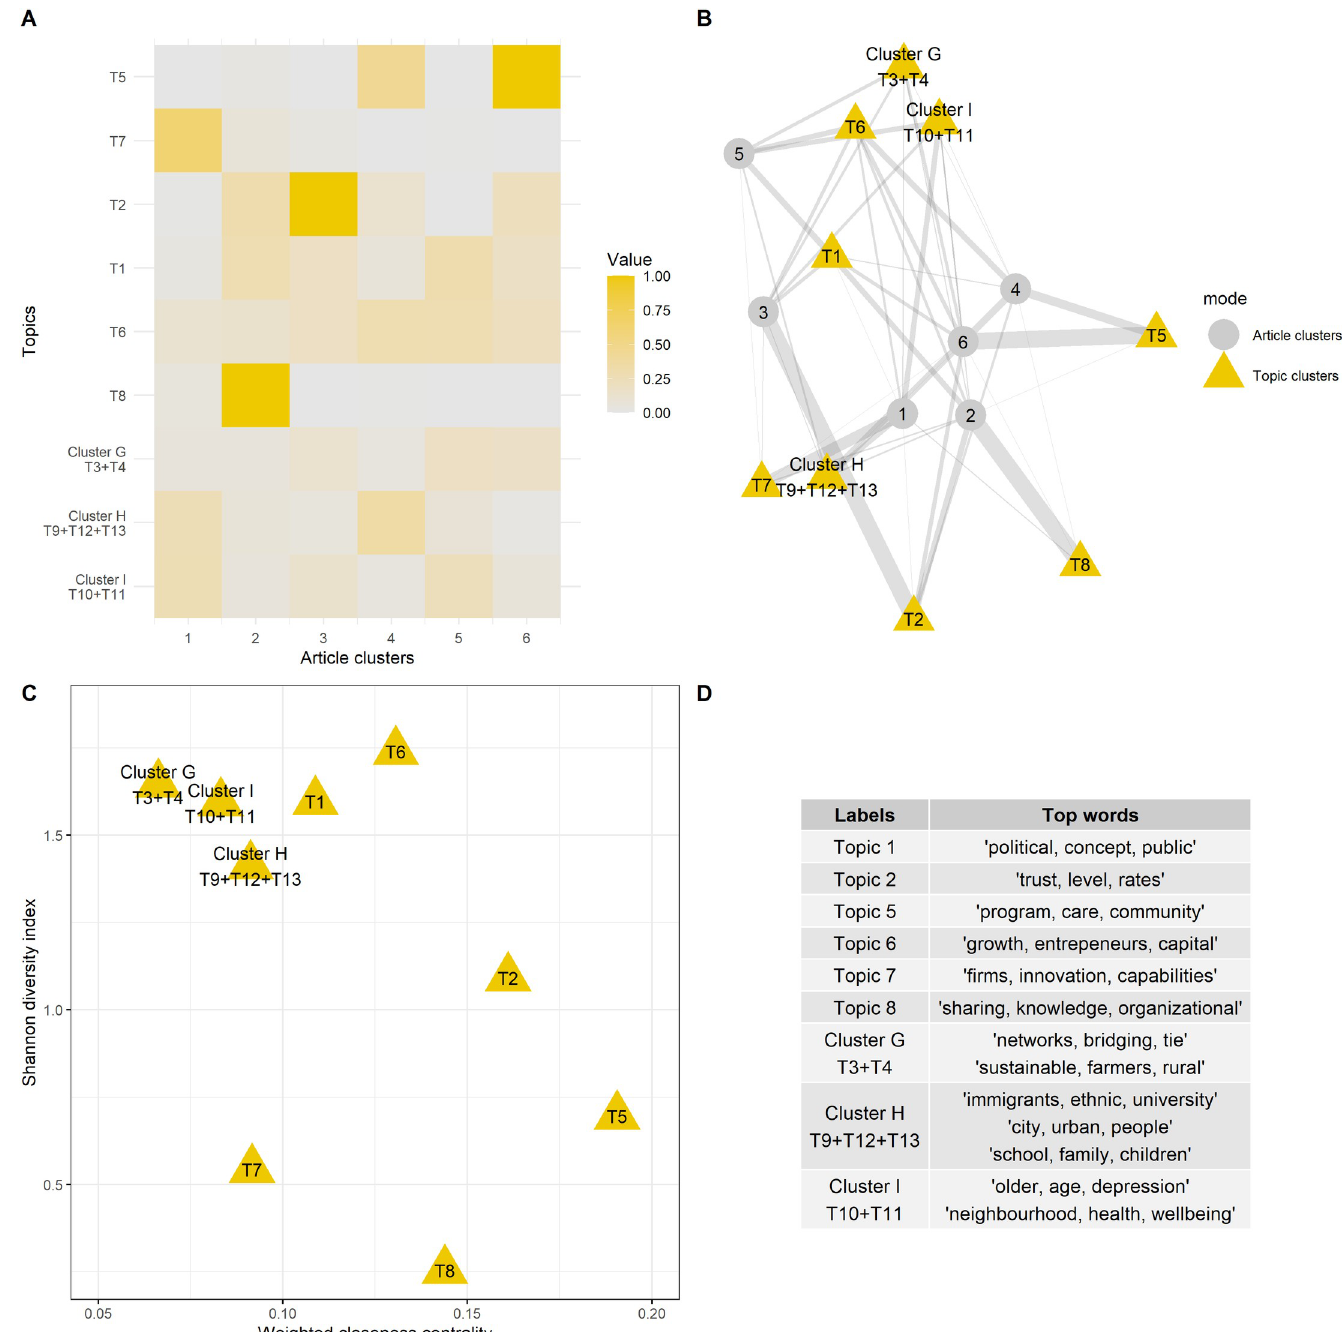
Fig 2. Results of the bipartite clustering